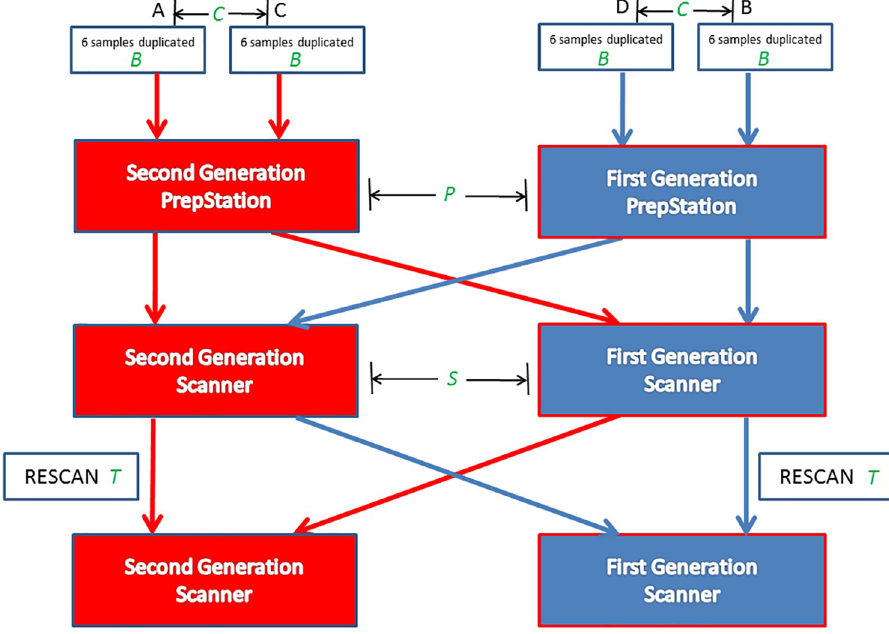
Fig 1. Diagram of experiment design. Four cartridges (A, B, C, D) were used to profile miRNA expression of 6 duplicated biological samples. Two RNA preparation methods and two scanners were combined for different cartridges. Effects in ANOVA models are labeled in green